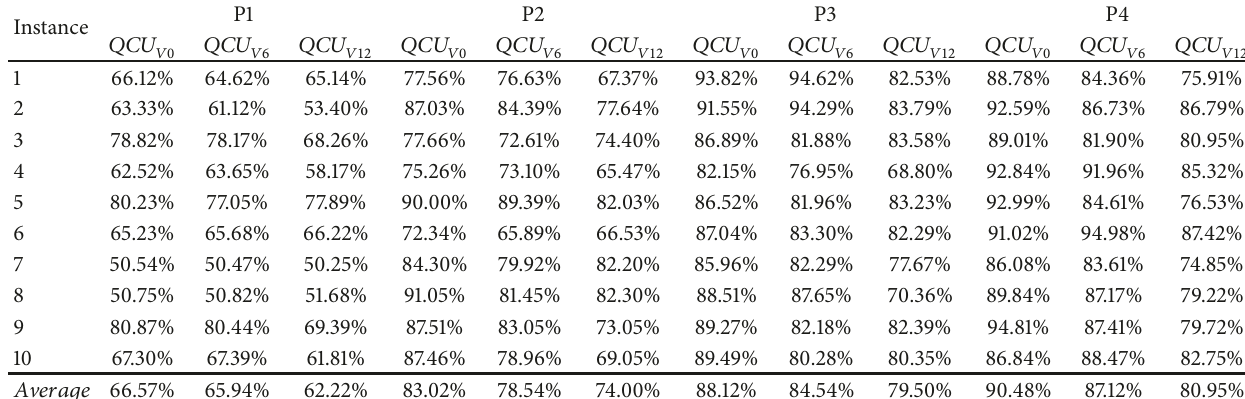
Table 9: Tidal impact on QC utilization